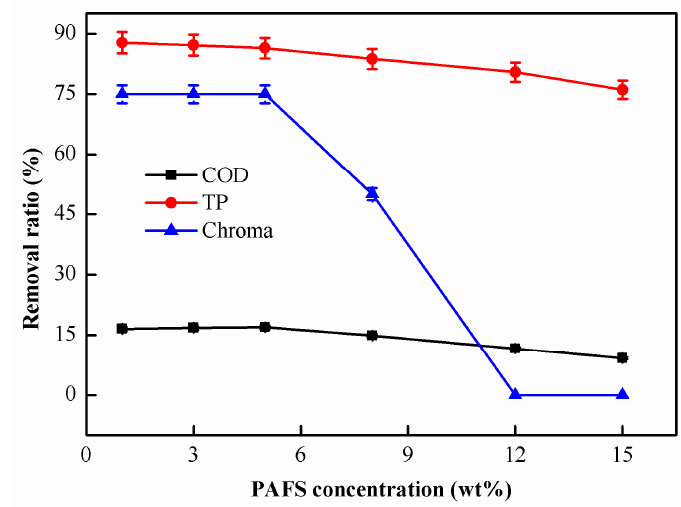
Figure 4. Effect of PAFS concentration on coagulation performance.